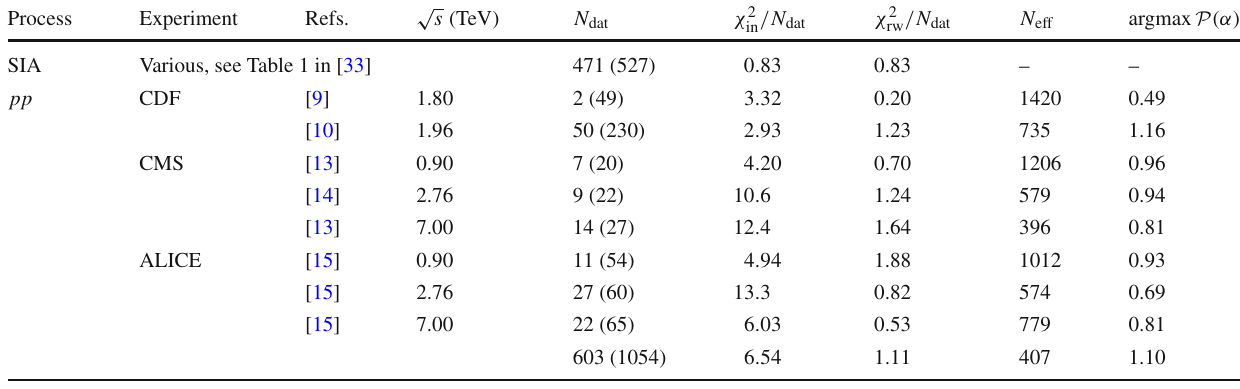
Table 1 The data set included in the NNFF1.1h analysis. For each hadron collider experiment, we indicate the publication reference, the √ s , the number of data points included after centre-of-mass energy (before) kinematic cuts N dat , the χ 2 per number of data points before